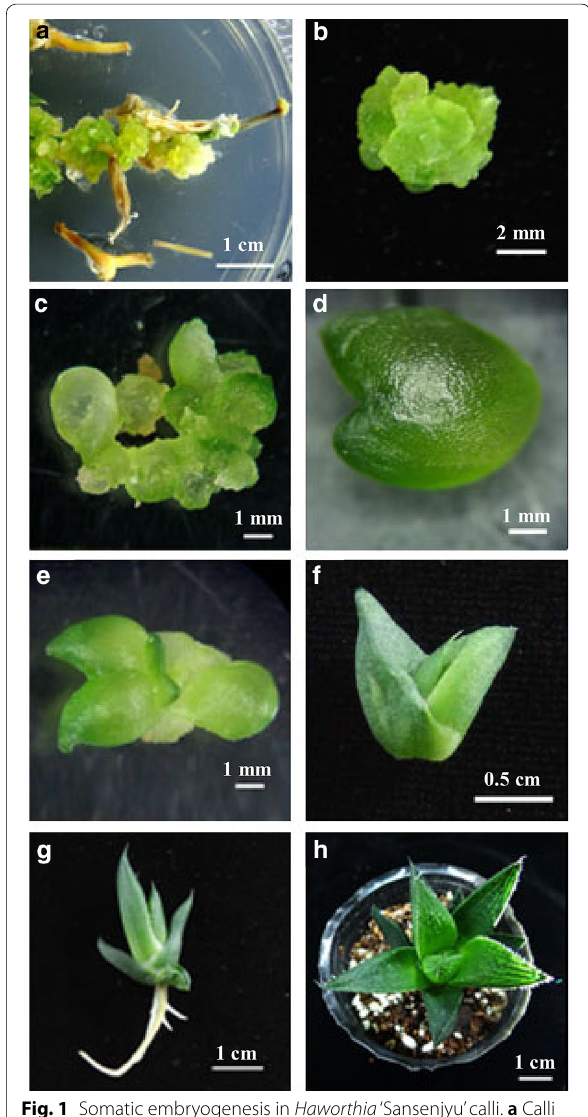
Fig. 1 Somatic embryogenesis in Haworthia ‘Sansenjyu’ calli. a Calli initiation from inflorescences, b embryogenic calli, c globular stage somatic embryo, d heart stage somatic embryo, e shoot formation, f plantlet, g root formation, and h acclimated